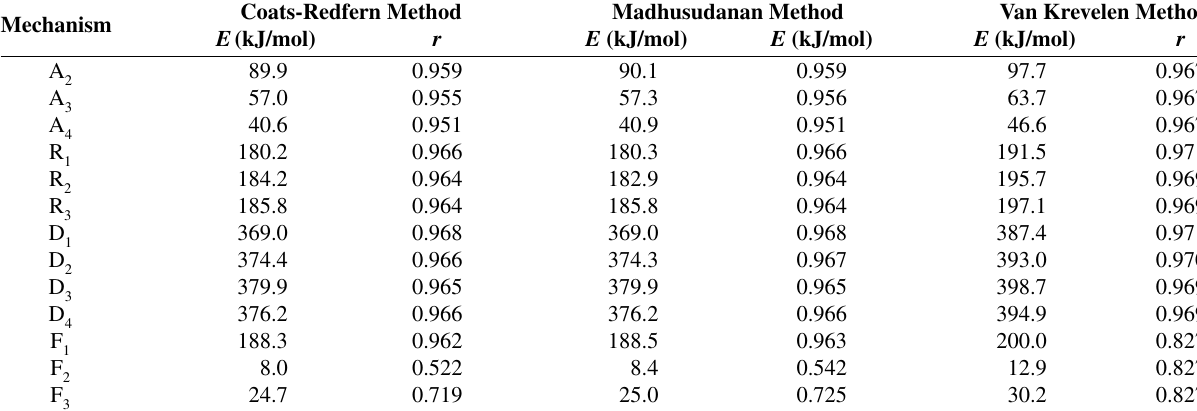
Table 5. Activation energies obtained for several solid state processes at a heating rate of 20 °C/min Coats-Redfern